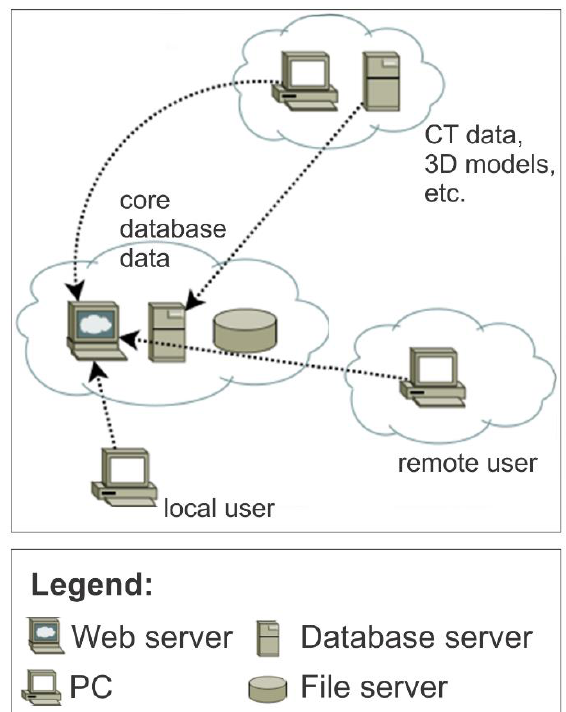
Figure 1. Relations between various servers and distribution of data among them. Users can access data directly or